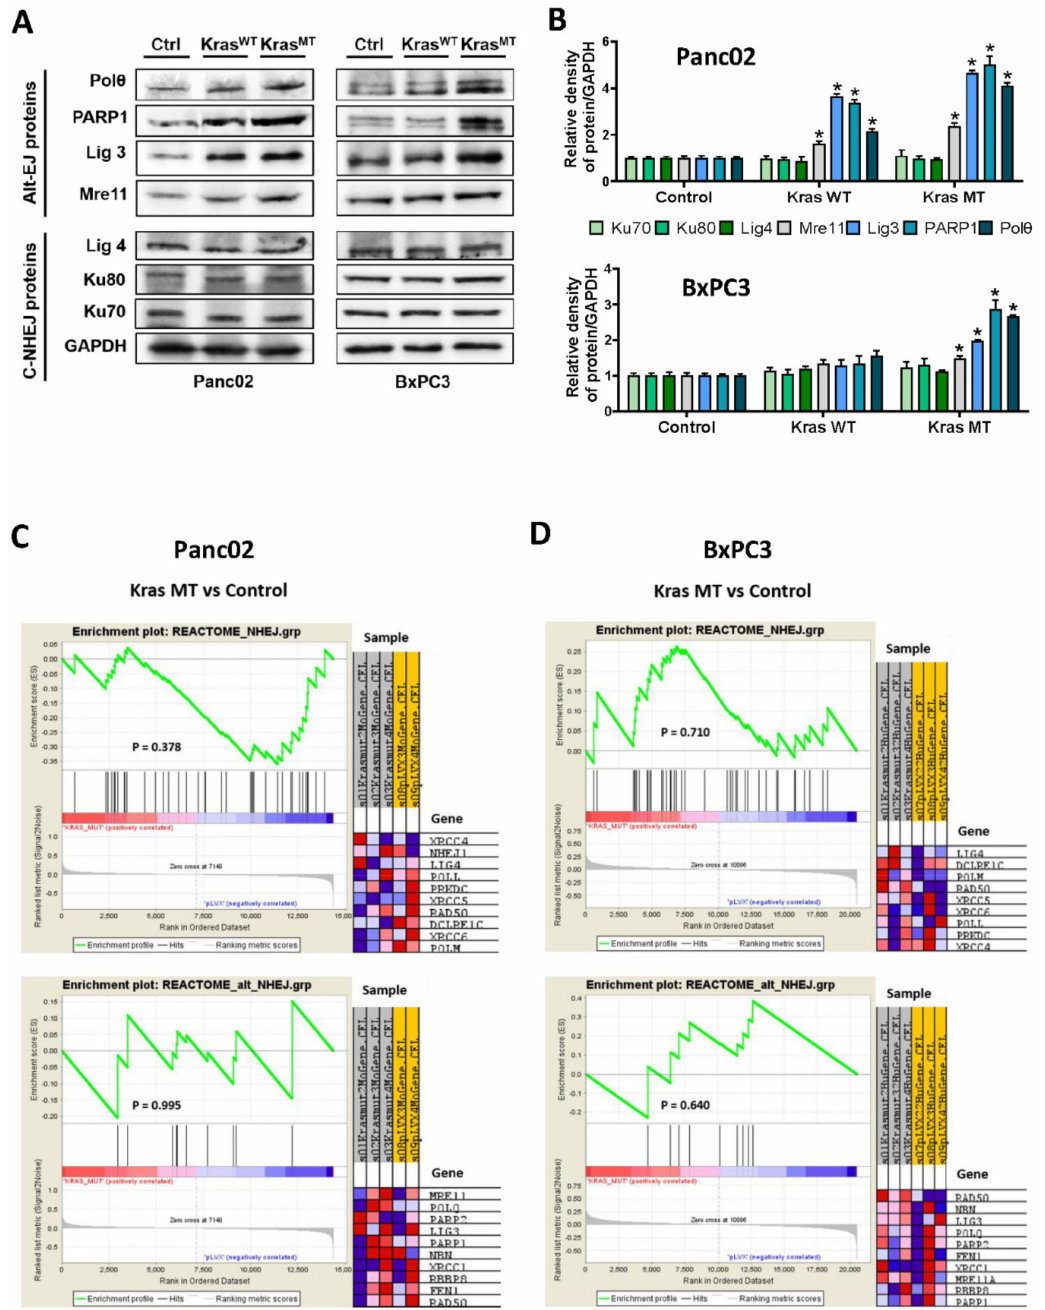
Figure 1. Impact of KrasWT and Kras G12D mutation on expression levels of alt-EJ components. ( A ) Protein expression of Pol θ , PARP1, Lig3, Mre11, Lig4, Ku80, and Ku70 in cell extracts isolated from transduced Panc02 and BxPC3 cells, and their respective quantification, are presented. Representative immunoblots from three independent experiments are shown. ( B ) Bar graphs show protein expression levels relative to GAPDH in Panc02 and BxPC3 determined by the means of densitometry of three independent experiments (mean ± SD; * p < 0.05 is considered as significant; Student’s t − test). The uncropped blots and molecular weight markers are shown in Supplementary Figure S4. ( C , D ) Gene Set Enrichment Analysis plots for the Reactome NHEJ and alt-EJ in Panc02 and BxPC3 cells are shown. The heatmap on the right side of each panel visualizes the genes contributing the most to the enriched pathway. The green curve corresponds to the enrichment score (ES) curve, the running sum of the weighted enrichment score in GSEA. p values are reported within each graph (Panc02 control, n = 2; Panc02 KrasMT, n = 3; BxPC3 control, n = 3; BxPC3 KrasMT, n =